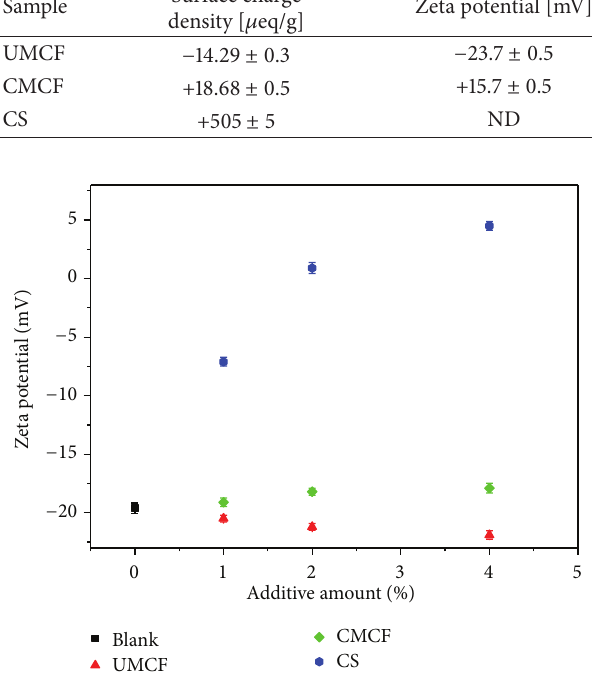
Figure 5: Zeta potentials of pulp suspensions with various additive amounts of three kinds of additives (UMCF, CMCF, and